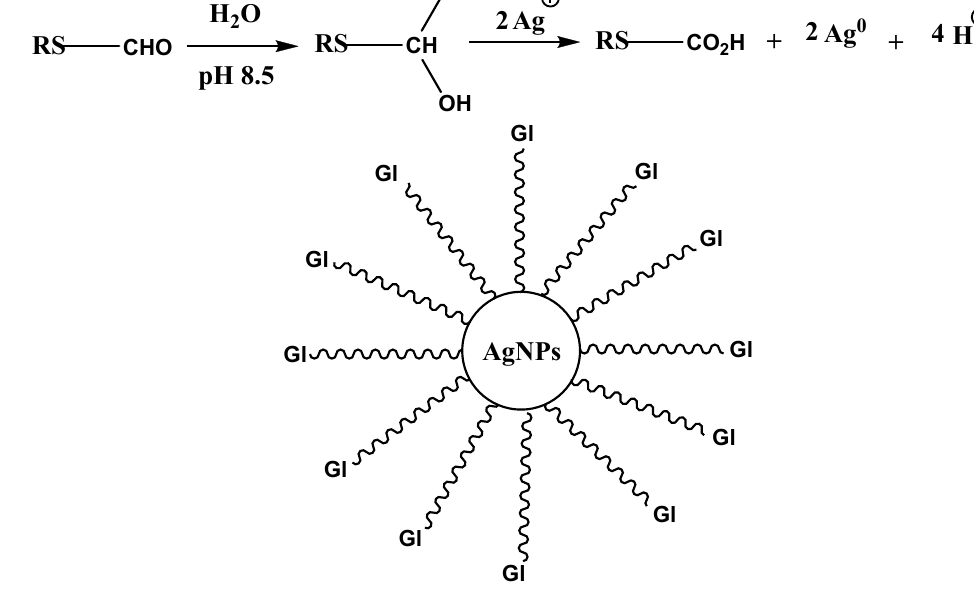
Scheme 1. Possible mechanism for the formation of gelatin (Gl) stabilized